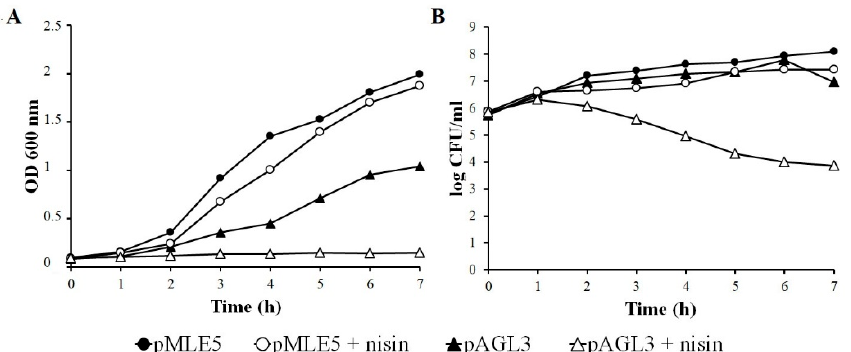
Figure 5. E ff ect of intracellular Tgl protein on ( A ) growth and ( B ) survivability of nisin-treated S. aureus cells. Overnight cultures of S. aureus cells bearing pAGL3 ( tgl + ) or pMLE5 plasmid (empty control vector) were diluted 1:100 in LB and incubated at 30 ◦ C until reaching optical density (OD 600 ) of about 0.1. At time zero, cultures were transferred to 42 ◦ C, supplemented with nisin concentrate (50 µ L per 25 mL S. aureus culture), and incubated further. Parallel samples without nisin served as controls. Each curve shows representative result of one of three independent experiments.